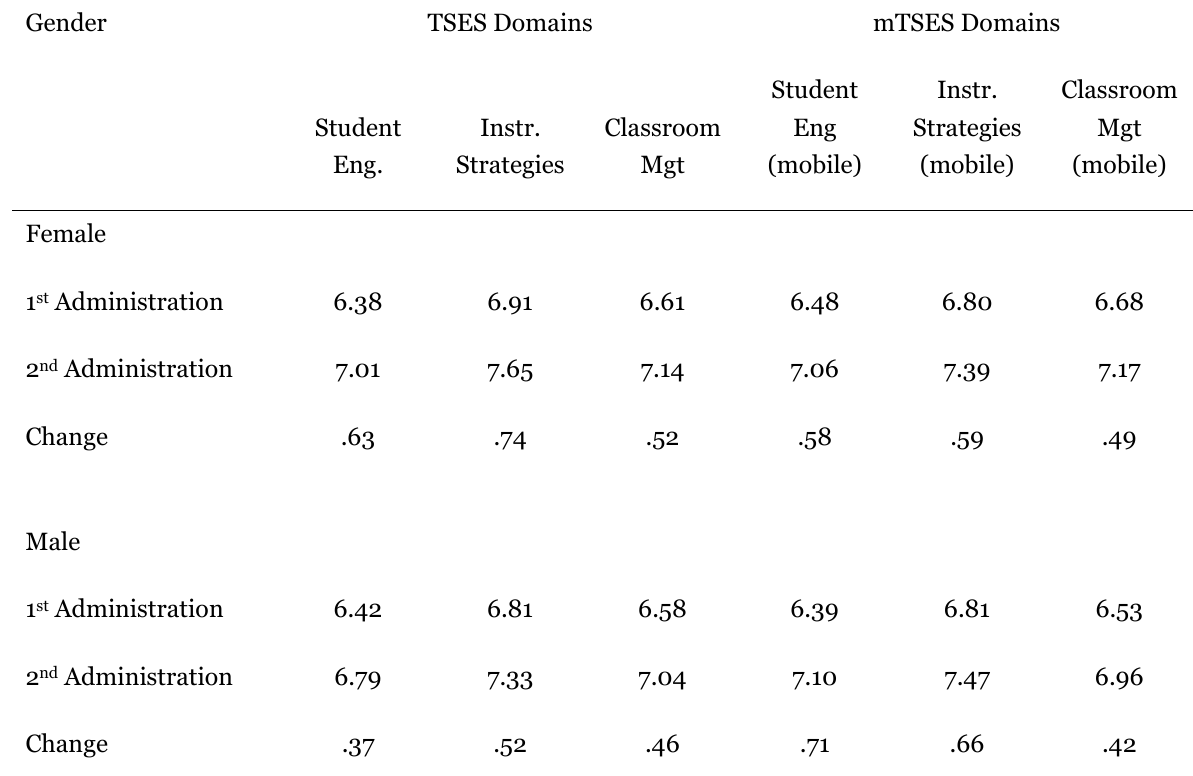
Changes in TSES and mTSES Scores in ID4ML by